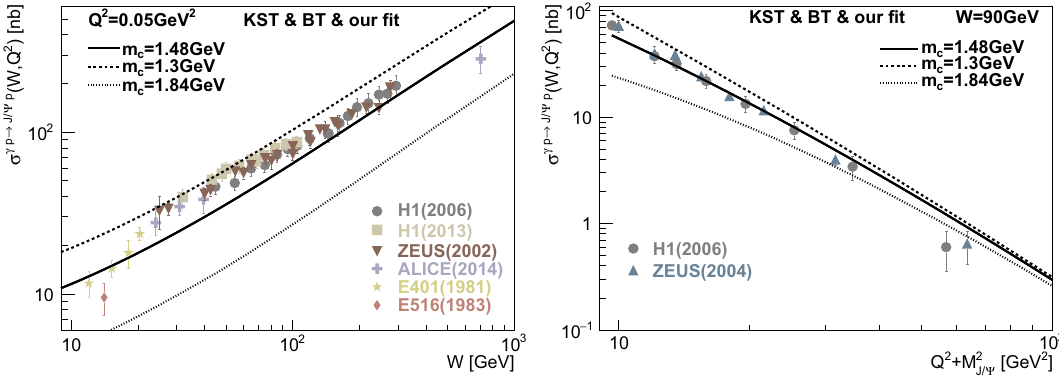
[GeV]10 2 10 W Fig. 17 The same as Fig. 7 but for the test of sensitivity of the model predictions to the typical charm quark mass m c variations